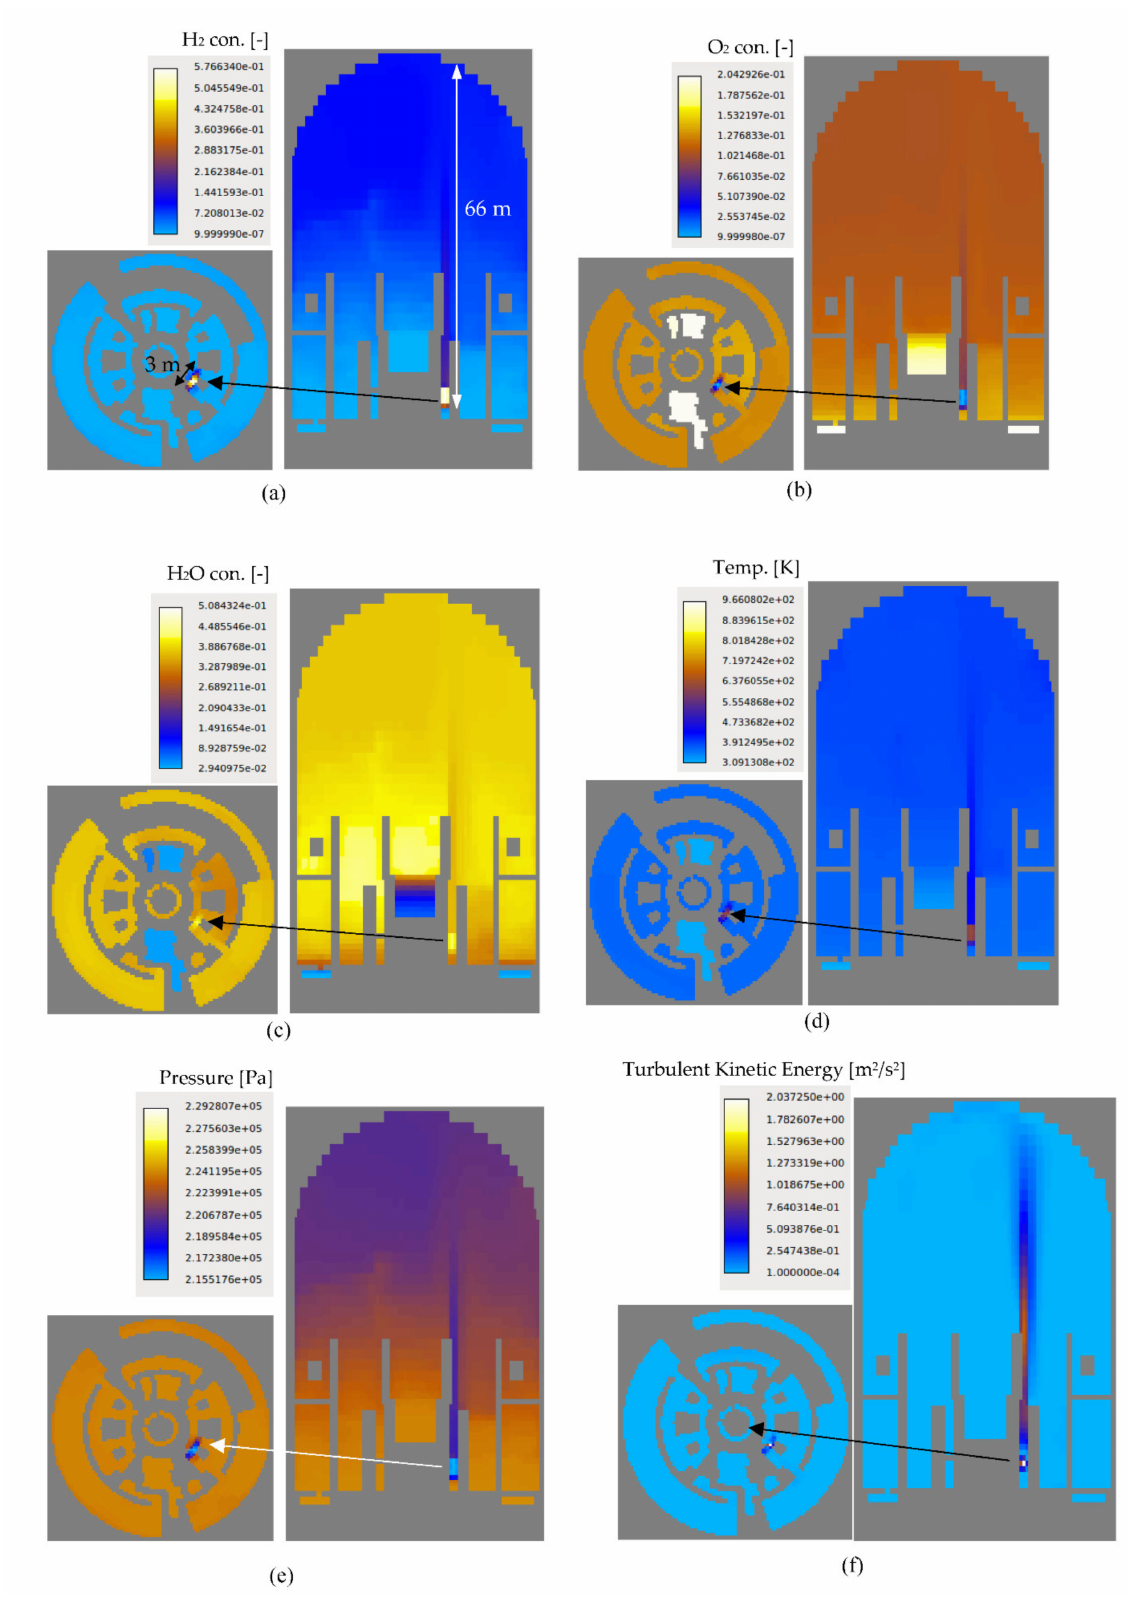
Figure 6. Initial conditions of the COM3D calculation for the severe accident. ( a ) Hydrogen Con- centration. ( b ) Oxygen Concentration. ( c ) Steam Concentration. ( d ) Temperature. ( e ) Pressure. ( f ) Turbulent Kinetic